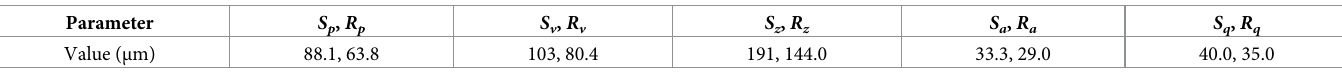
Table 2. Measured roughness parameters, height surface roughness (ISO 25178) as well as amplitude-roughness (ISO 4287) after Gaussian filter with a cut-off value of 0.8 mm was applied.